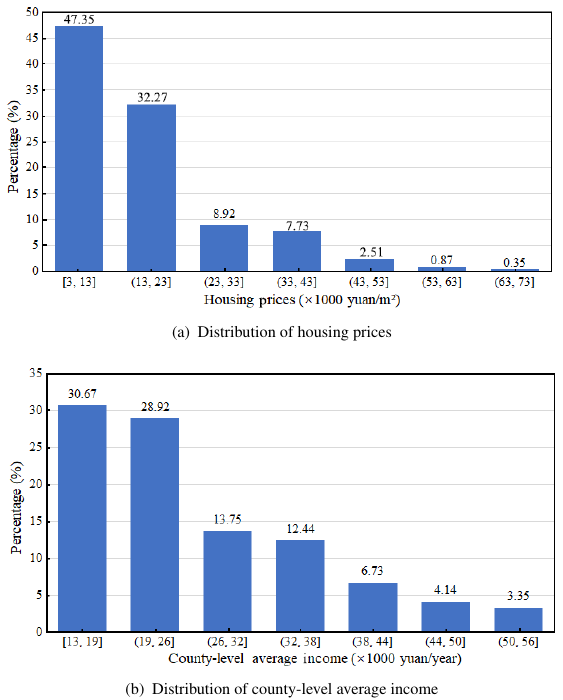
Fig. 1 Distributions of housing prices and county-level income in